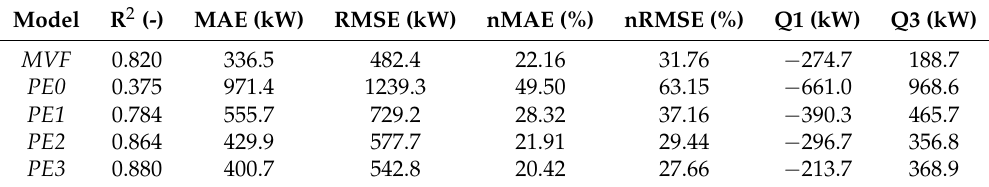
Table 4. Error analysis on net load forecast for different prediction strategies. PE1 is the net load forecast obtained using a SVR using as predictors the time series of net load itself and the meteorological forecast for GHI and wind speed at 100 m from the ground; PE2 is the SVR predictor using all the predictors used for PE1 with the addition of the features used for NL3 ; PE3 is the net algebraic sum obtained summing the NL3 forecast with the MVF forecast; MVF shows errors of the medium voltage production forecast. The values of nMAE and nRMSE are normalized with respect to the mean value of the measured